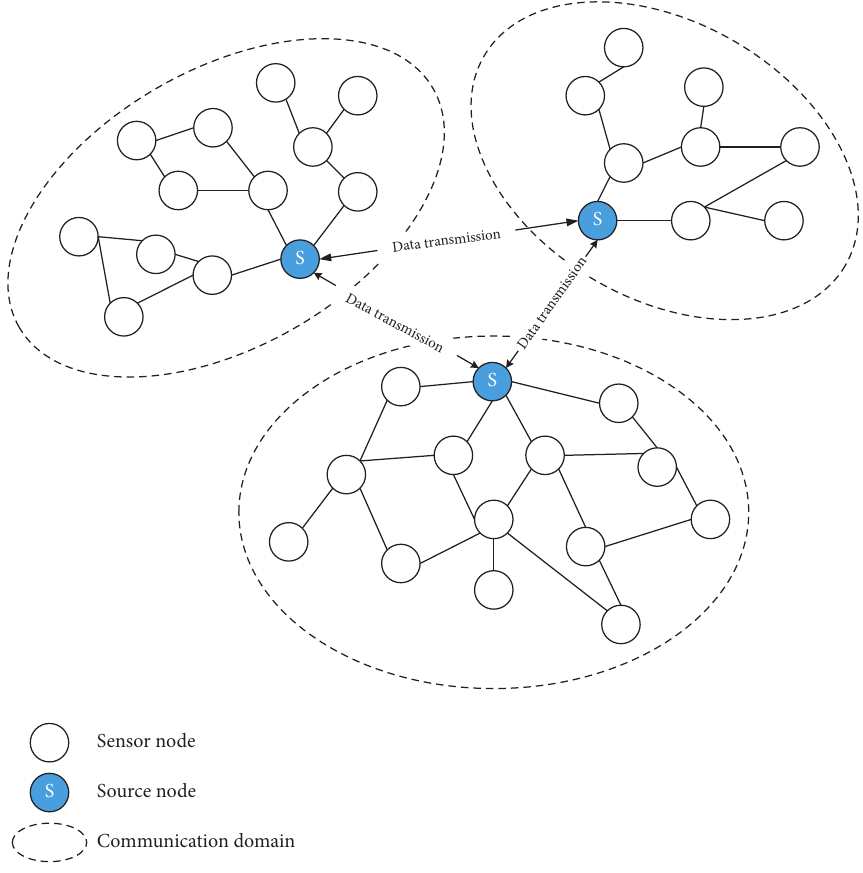
Figure 1: Data delivery on communication